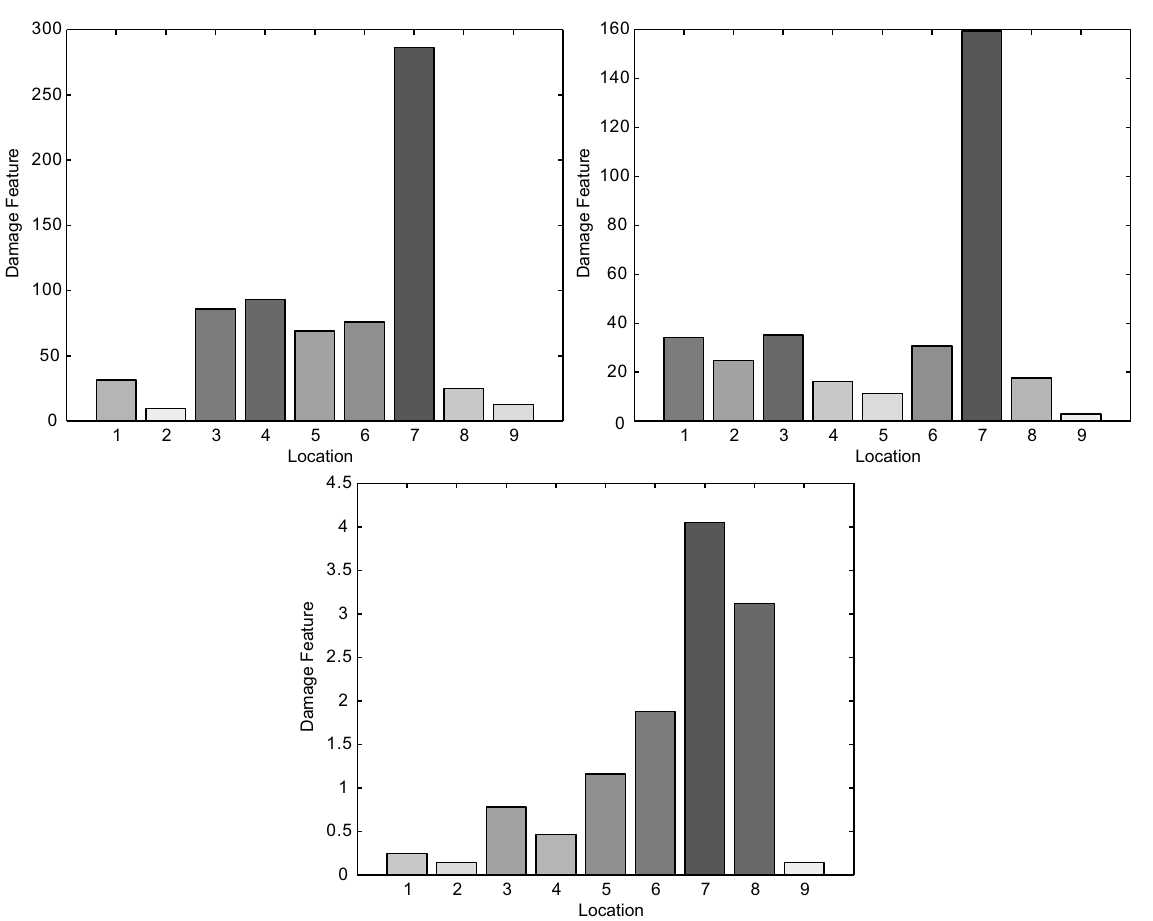
Fig. 6. Damage feature, frequency range 1–200 Hz (top left), frequency range 60–120 Hz (top right) and frequency range 10–40